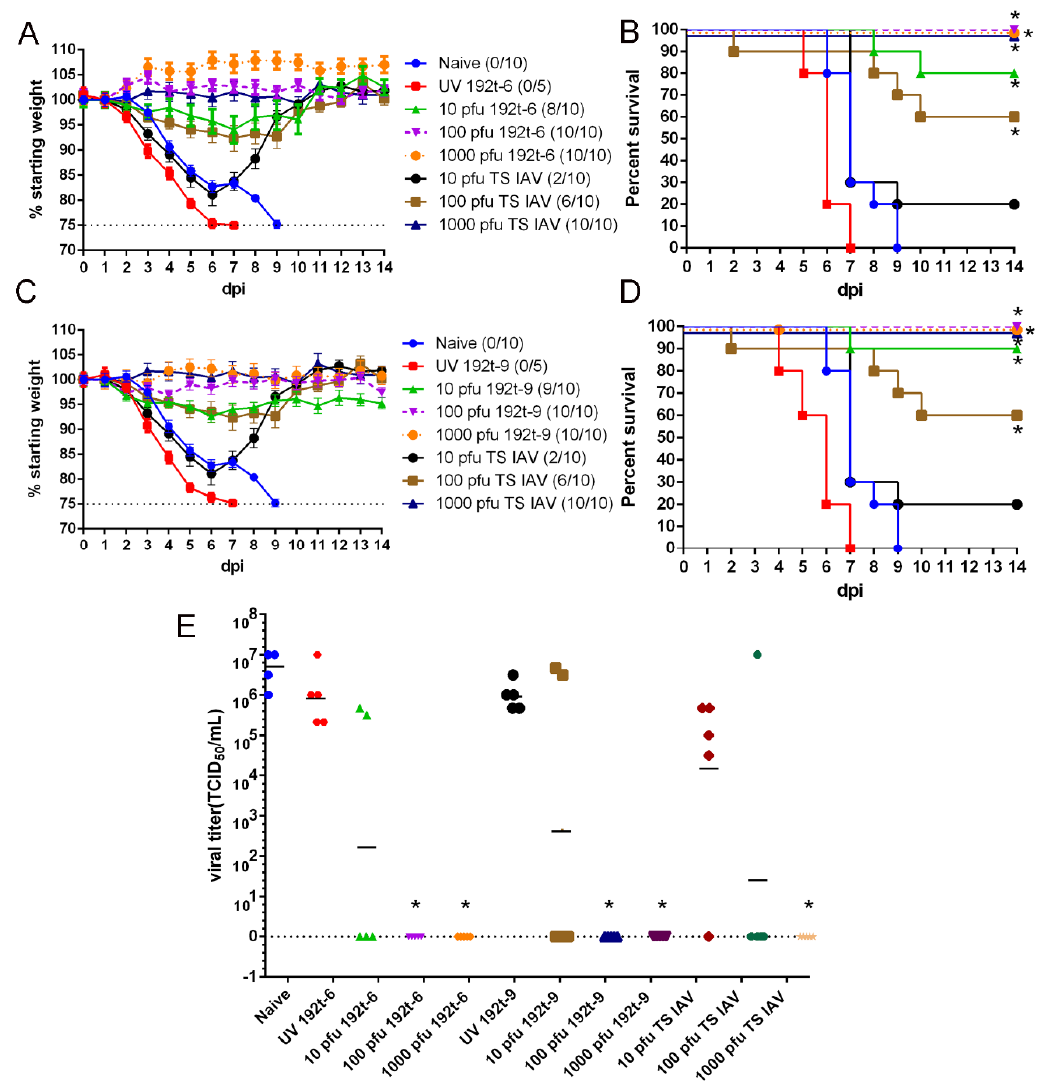
Figure 4. miRNA targeted viruses of 192t-6 and 192t-9 provide protection against homologous virus challenge. Mice were immunized i.n. once with various doses of 192t-6, 192t-9 and TS IAV which was as the positive control group, and naive, UV 192t-6 and UV192t-9 which were as control groups. Four weeks after immunization, mice were challenged with a high lethal dose of 10 × LD 50 PR8 influenza virus. Bodyweight changes ( A , C ) and survival rates ( B , D ) of mice were measured daily for two weeks after challenge. * p < 0.05, compared to the naive group. ( E ) The lung viral titers of all mice were determined by TCID 50 on three days after the challenge. Data shown as mean, n = 5 per group. Each sample was tested in triplicates. Dotted line represents limit of detection. * p < 0.05, compared to the naive group.